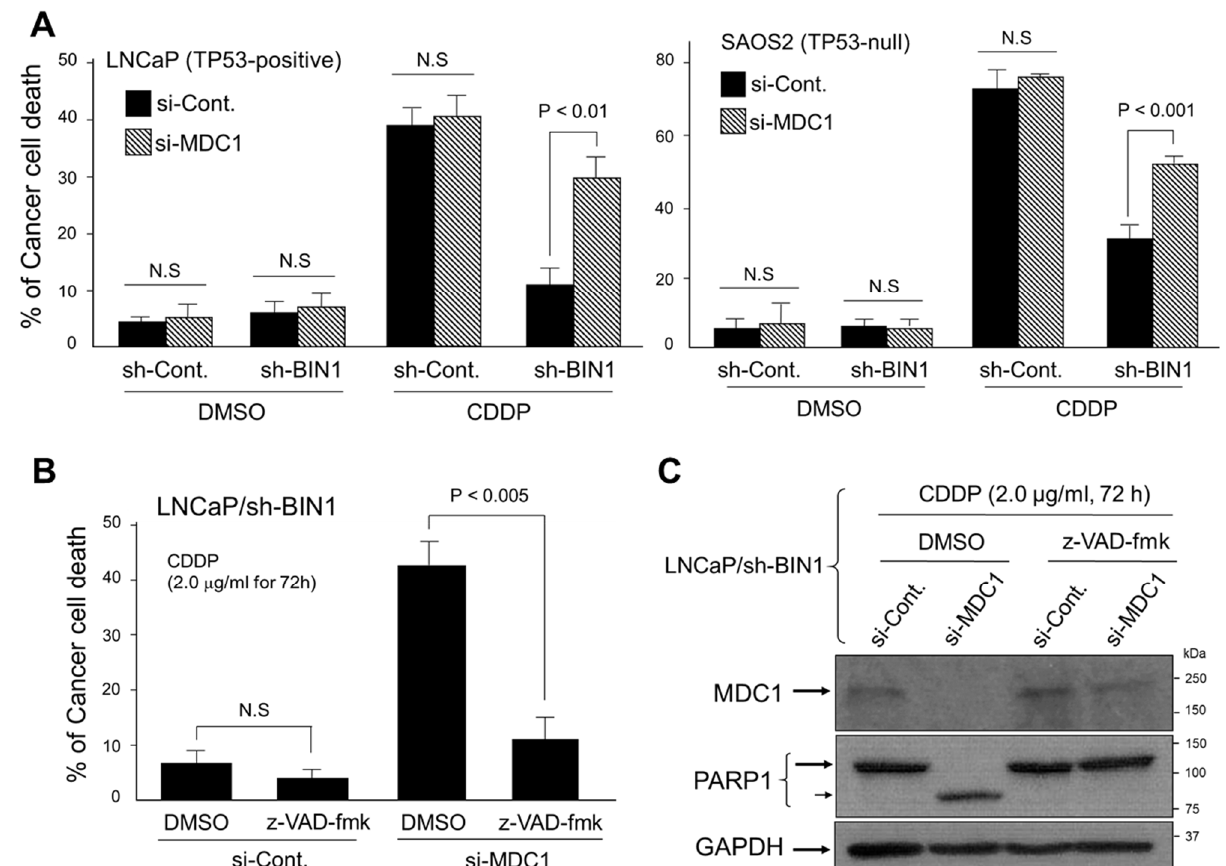
Figure 3. MDC1 depletion causes caspase-dependent cell death by cisplatin, thus compromising the cisplatin resistance due to a BIN1 loss. ( A ) Trypan blue exclusion assays of the cisplatin-sensitive cancer cell lines (LNCaP and SAOS2) ± sh-BIN1 in the presence and absence of cisplatin (CDDP, 2.0 µg/mL, 72 h). The scrambled sh-RNA-expression vector was used as the negative control (sh-Cont). Twenty-four hours before the treatment with cisplatin, actively growing cells were transiently transfected with si-MDC1 or si-Control RNA; ( B ) trypan blue exclusion assays demonstrated that the cisplatin sensitivity obtained by si-MDC1 was counterbalanced by z-VAD-fmk (20 µM) in the LNCaP/sh-BIN1 cells; ( C ) Western blotting analysis revealed that endogenous PARP1 protein is cleaved during cisplatin-induced apoptosis elicited by si-MDC1 in the LNCaP/sh-BIN1 cells.